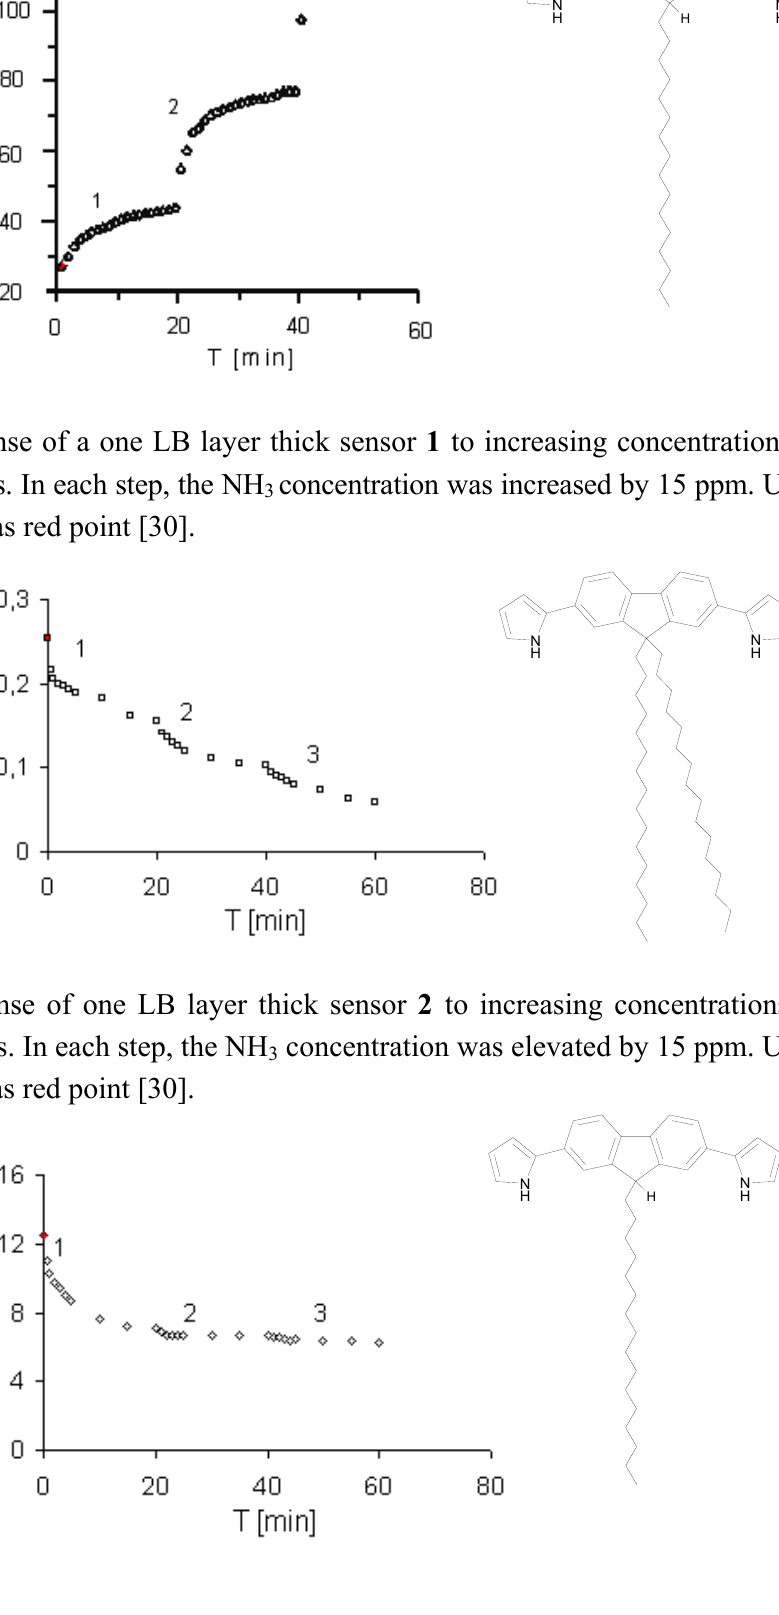
Figure 3. Response of a one LB layer thick sensor 2 to increasing concentrations of NO during 60 minutes. In each step, the NO U = 0.5 V, the initial signal as a red point [30].